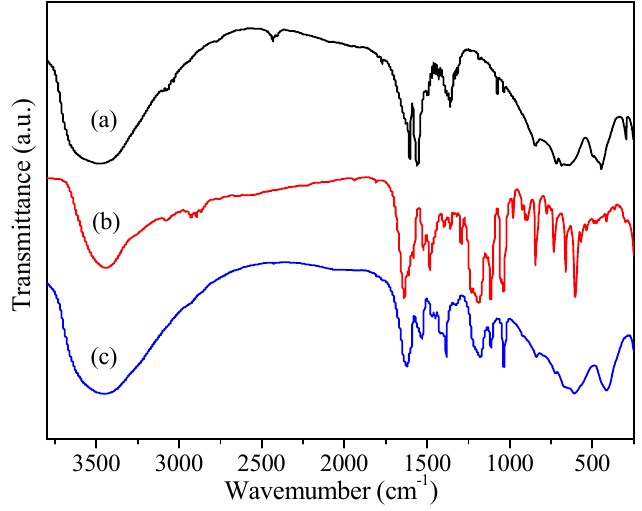
Figure 1. FTIR spectra of ( a ) CuMgAl-LDH; ( b ) Cr(SO 3 -salen); ( c ) Cr(SO 3